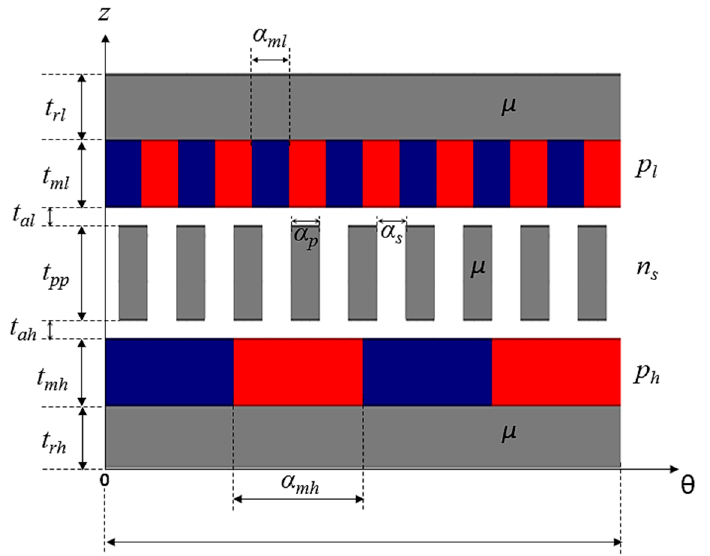
Figure 2. Two-dimensional model of the AFMG. For the chosen configuration, i.e., p l = 7, ph = 2, and n s = 9, the AFMG is divided into seven layers in the axial direction ( z ) to take into account the different materials. The min- imum repetitive unit in that direction, i.e., the ferromagnetic pole pieces, determines the number of divisions in the circumferential ( θ ) direction [26]. Each ferromagnetic pole piece and each slot between them is divided into an integer number of reluctance